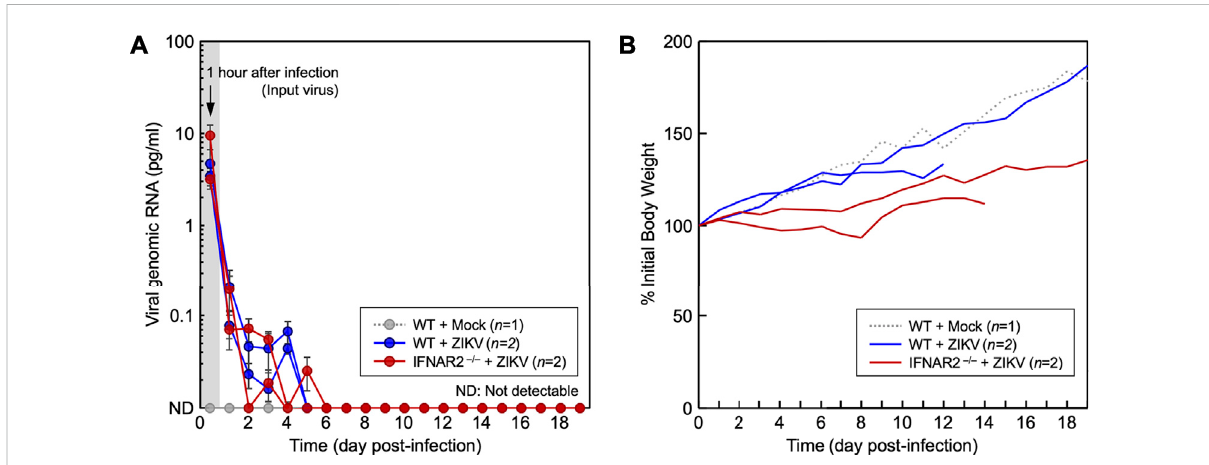
FIGURE 6 Study of ZIKV replication in WT and IFNAR2 − / − lambs. One-month-old WT ( n = 2) and IFNAR2 − / − ( n = 2) ewe lambs were each inoculated intravenously with 2.0 × 10 6 PFU of ZIKV PRVABC-59. As a control, an age- and sex-matched WT lamb was mock-infected. (A) The amount of viral genomic RNA, an indication of viral replication, was quantitated by qRT-PCR using the blood specimens taken daily for 19 days after infection. The amount of viral genomic RNA detected at 1-h post-infection serves as a reference for the viral inoculum. The amount of viral genomic RNA for each sample was determined based on a standard curve generated using a full-length infectious cDNA clone of ZIKV PRVABC-59. (B) Body weights were recorded daily and plotted as the changes in body weight relative to the initial value at day zero.